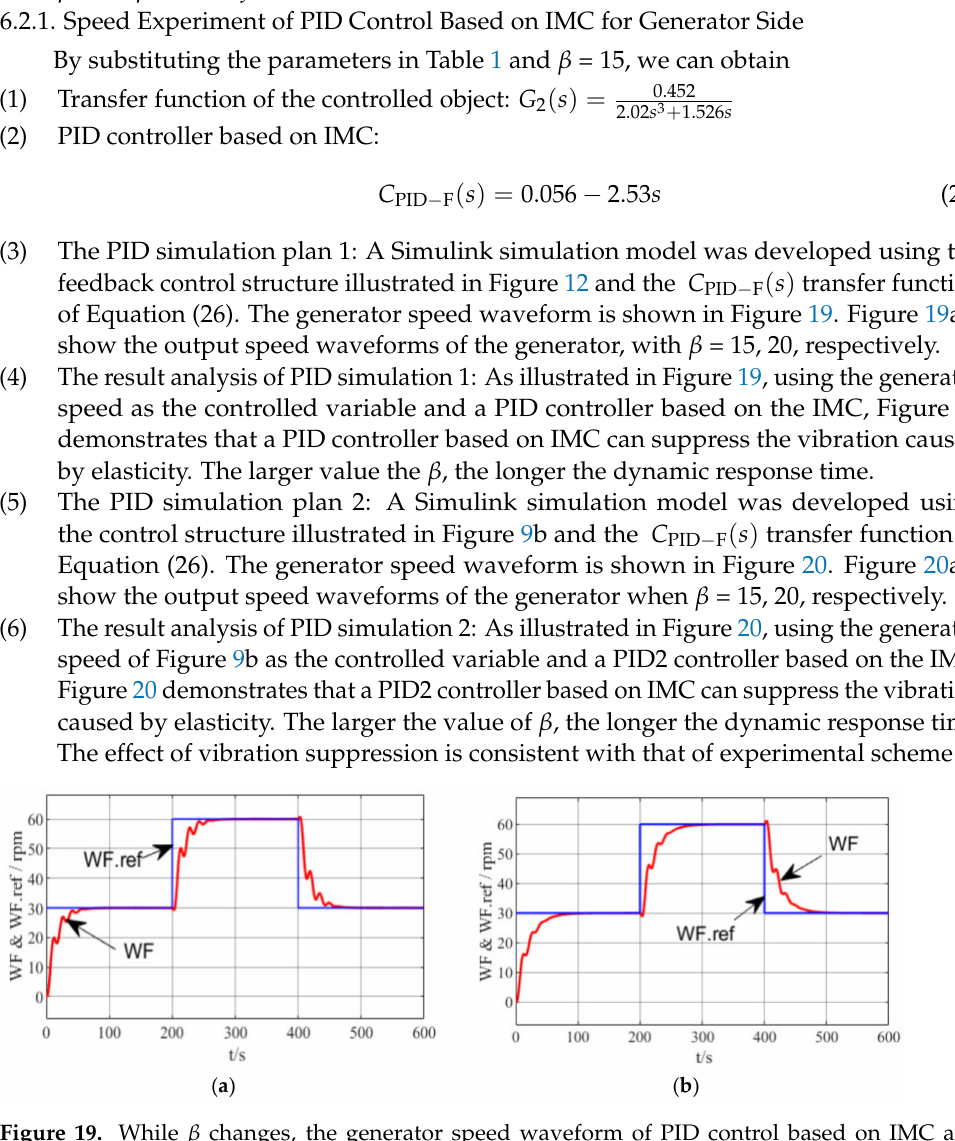
Figure 19. While β changes, the generator speed waveform of PID control based on IMC and experiment scheme 1. ( a ) The speed waveform of β = 15, ( b ) The speed waveform of β =